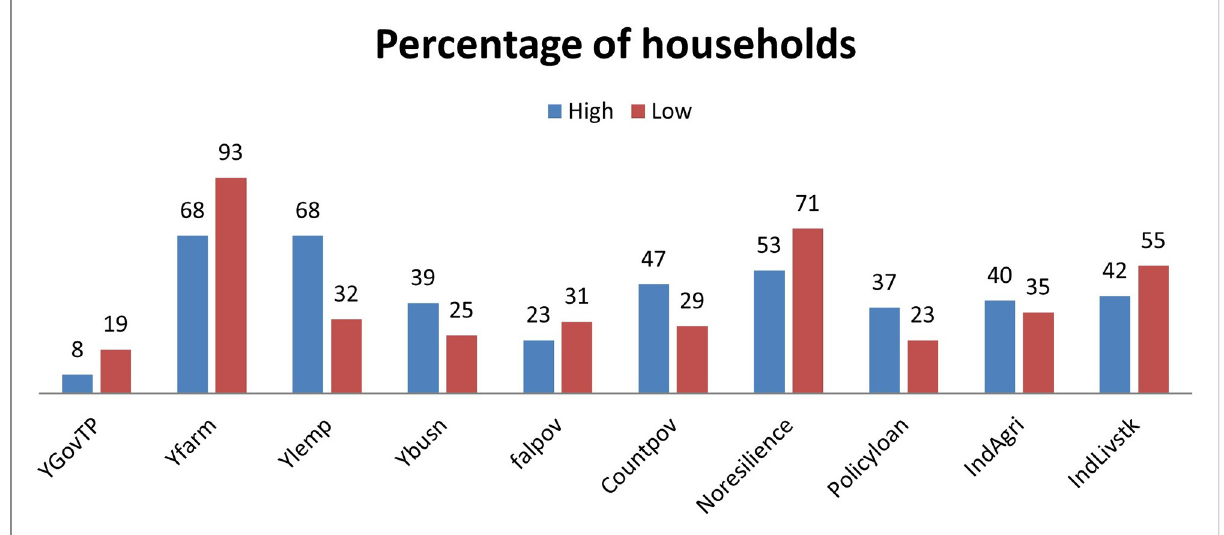
Fig 2. High and low SES households.